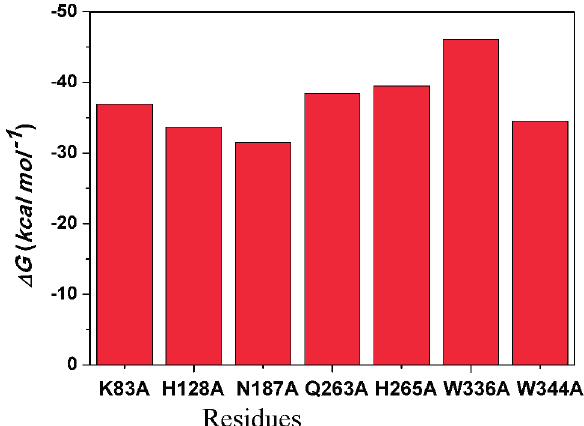
Figure 10. Computational alanine mutants (kcal·mol − 1 ) calculated for the X4(sb)–Xyn10A (red